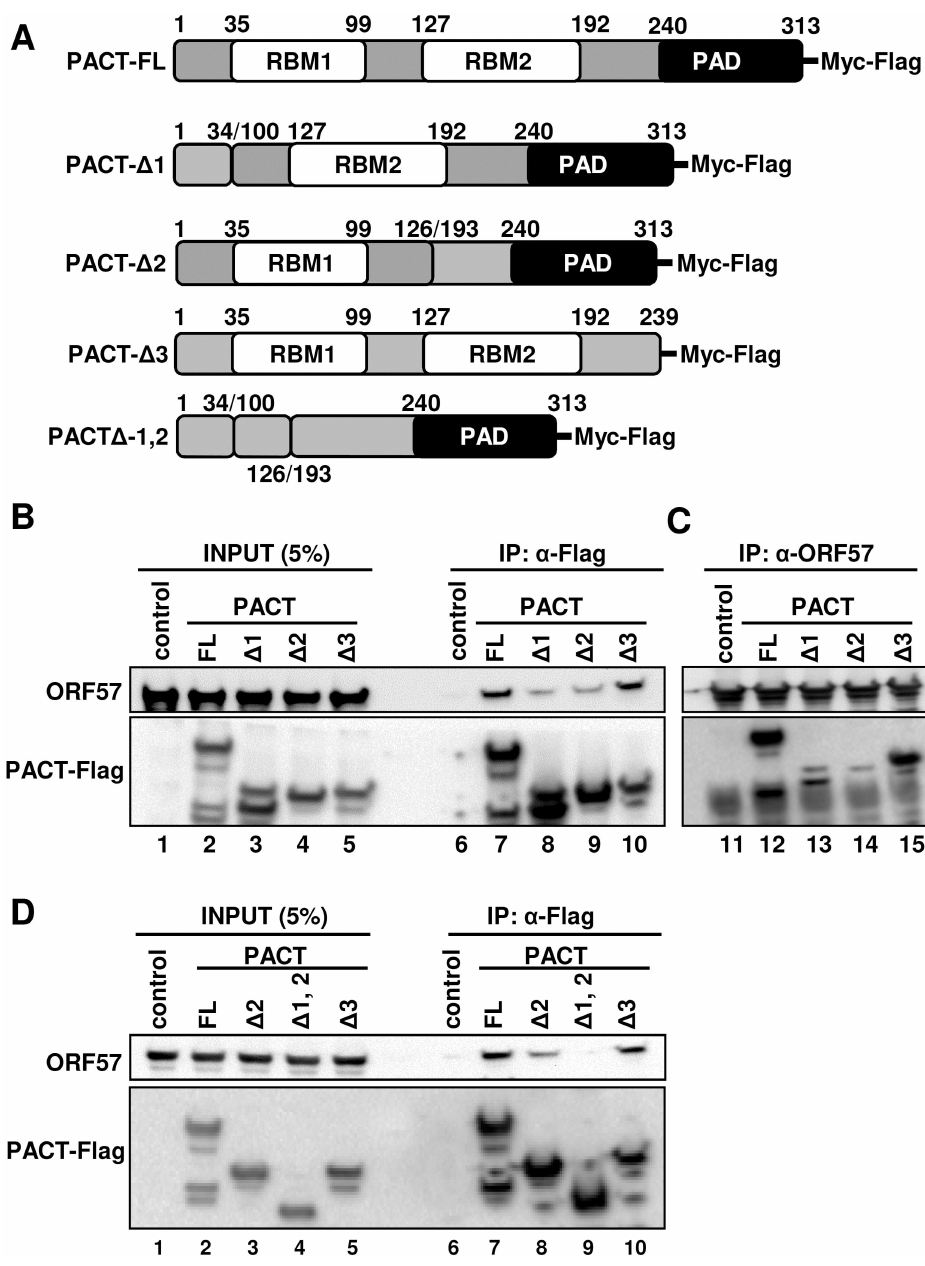
Fig 6. ORF57 interacts with PACT via its RBM1 and RBM2 motifs. (A) Schematic diagrams(not in scale) of full-length(FL) wt PACT and its deletionmutants. PACT containstwo RNA-binding motifs (RBM1 and RBM2) and a PKR-activation domain(PAD). Numbersindicate the positionsof amino acid (aa) residuesfor each domain in PACT. A series of PACT deletionmutants either with Δ 1 missing RBM1 (aa 35–99), Δ 2 missing RBM2 (aa 127–192), Δ 3 missing PAD (aa 240–313)or doublemutant Δ 1,2 missing both RBM1 and RBM2) (aa 35–99 and aa 127–192) were generatedby overlapping PCR. (B-D) Mappingof ORF57-PACT interacting domains.HEK293 cell extract containingectopically-expressedMyc-Flag-PACT or its deletion mutant was mixed with the cell lysate containing untaggedORF57. The mixture was digestedwith RNase A/ T1 and subjectedto co-IP either with anti-Flag M2-coatedbeads (B, D) or with polyclonal rabbit anti-ORF57 antibody-coated beads(C). The proteins in the co-IP complexwere detected by Western blot with the corresponding